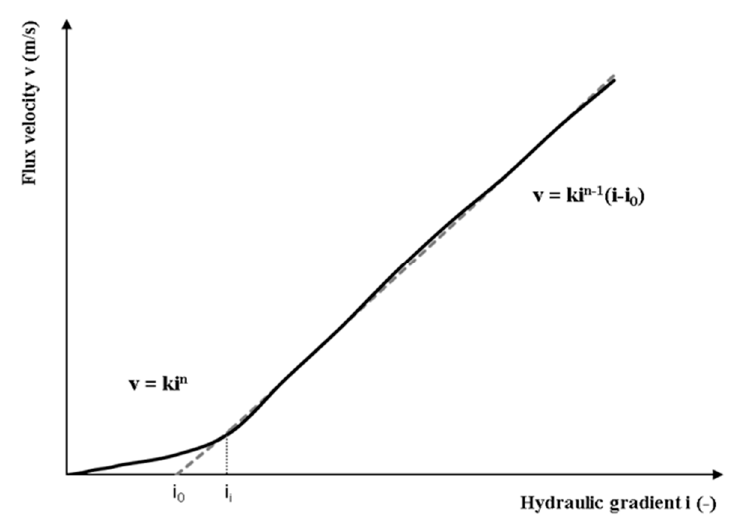
Figure 3. The relationship between the flux velocity and the hydraulic gradient in non-Darcian flow [28].